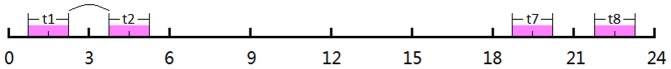
Television delay time calculation.